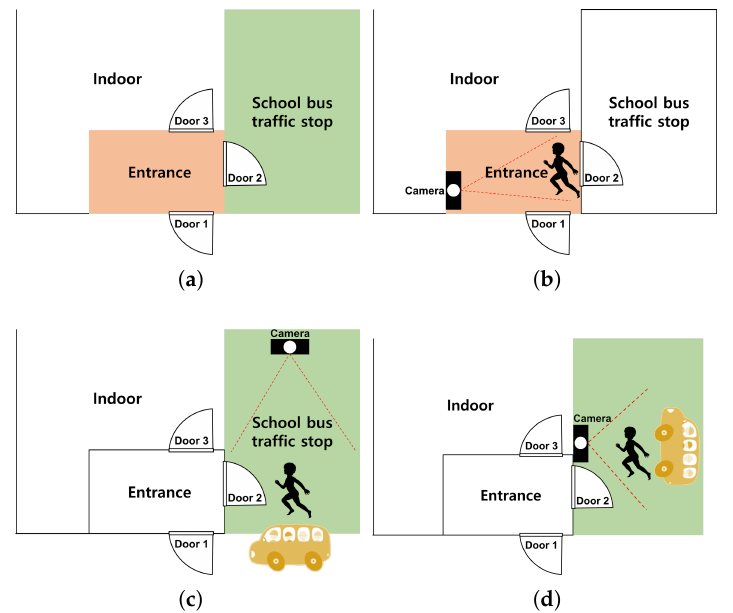
Figure 4. Camera installation location (outdoors): ( a ) outdoor structure of daycare center; ( b ) entrance; ( c ) school bus traffic stop; ( d )